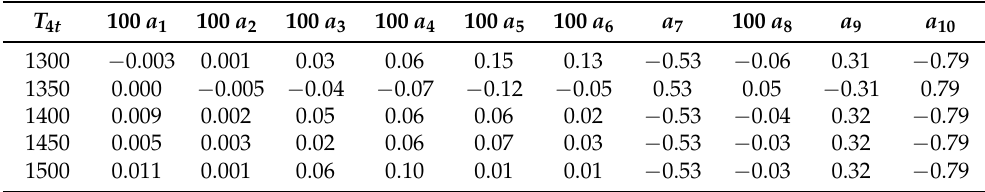
Table 7. The coefficients appearing in (30) for the values of T 4 t already considered in Table 6. T 4